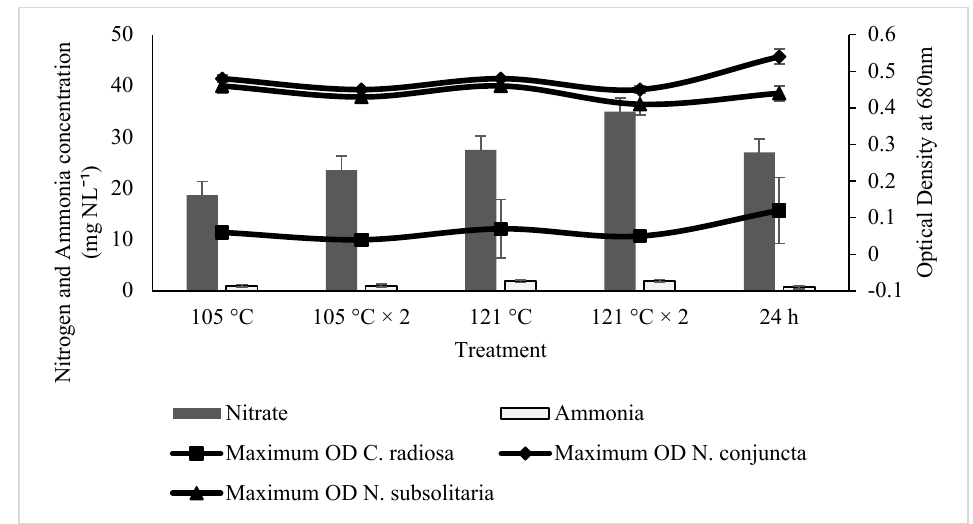
Figure 1. Effect of ammonia and nitrate concentration on the growth of C. radiosa, N. conjuncta , and N. subsolitaria from Raja Musa Forest Reserve (RMFR) with different extraction methods. Error bars represent standard deviation ( n = 3).